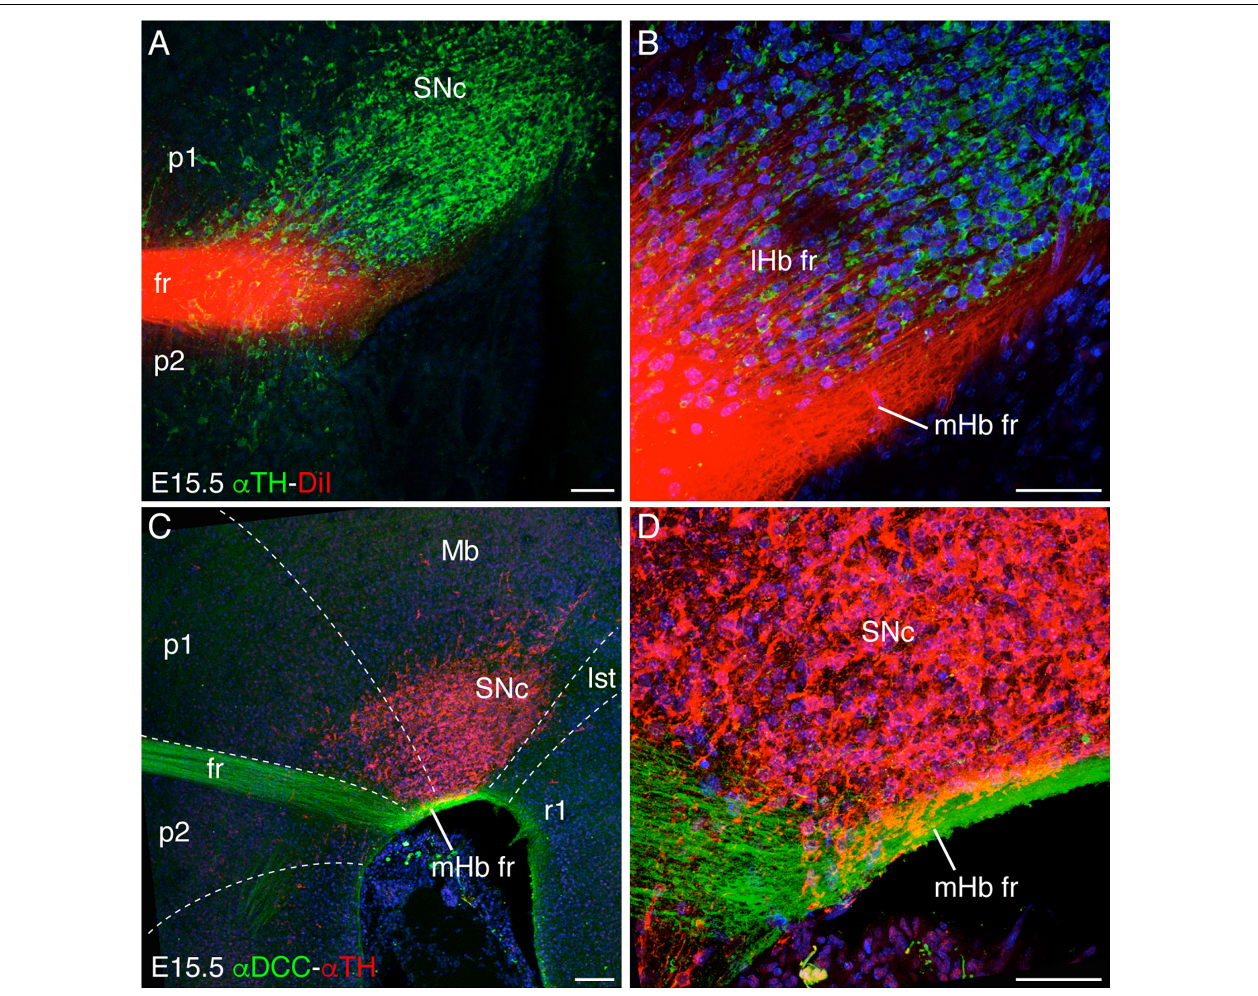
FIGURE 1 | Longitudinal navigation of habenular axons through the SNc and VTA. (A,B) DiI fr labeling and TH immunochemistry in E15.5 brain sagittal section. We differentiated the defasciculated lHb crossing the SNc and the compacted mHb axons in contact with the pial surface underneath the SNc to reach their target in r1. B is a higher magnification of A . (C,D) E15.5 brain sagittal section labeled against DCC and TH. DCC specifically labeled the mHb axons, which navigate underneath the SNc. D is a higher magnification of C . The white dotted lines define the boundaries between different neuromeres (p2, p1, Mb, Ist, and r1). Abbreviations: Ist, isthmus; lHb fr, lateral habenular axons of the fasciculus retroflexus; Mb, midbrain; mHb fr, medial habenular axons of the fasciculus retroflexus; p1, prosomere 1 (pretectum); p2, prosomere 2 (thalamus); SNc, substantia nigra pars compacta; r1, rhombomere 1; fr, fasciculus retroflexus. Scale bar: 100 µ m in A and C and 50 µ m in B and D